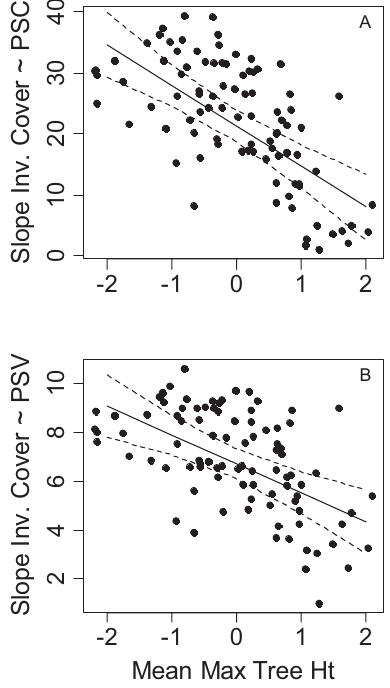
Figure 3. Effects of mean maximum tree height in 91 ecological sections on the degree to which PSC ( A ) and PSV ( B ) affect invasive species cover (i.e. slope values for these relationships). Note that values on x and y axes were transformed (z-transformed and [(x + abs(min(x)) + 1) 7 ], respectively) prior to analysis. Untransformed values for slopes were largely negative (Fig. 1; Suppl. material 3, fig.